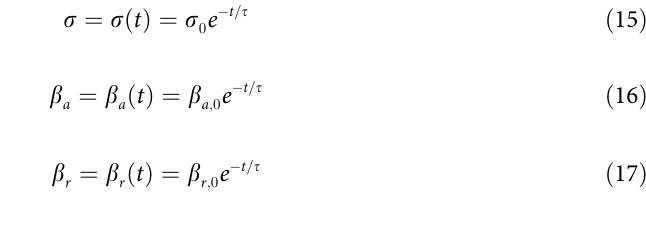
Fig 3. Attractant+repellent simulation. Panels A, D show density ρ , B, E show attractant concentration U concentration U r . The spatial units are centimeters. The two numbers below each plot are the minimum and maximum values of the plotted function over the entire 1 cm × 1 cm domain. Note the different scale of the attractant and repellent plots. The means are the same, but because repellent is a longer-range signal, it is smoothed much more by diffusion and varies less than attractant. (S4 and S5 Videos show the full time courses for these simulations. S2 Fig shows ten independent solutions of the two-dimensional system with different pseudorandom noise at time